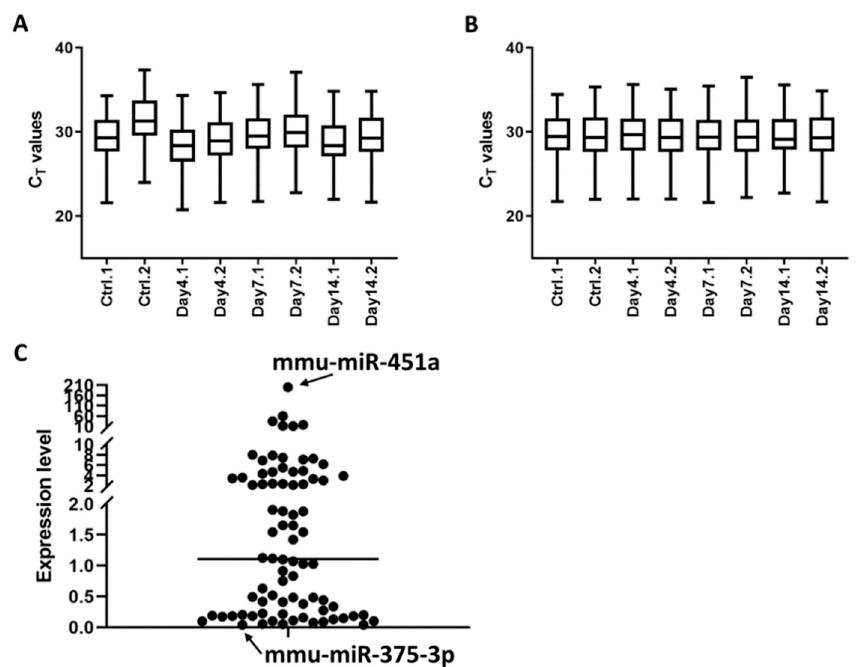
Figure 2. MicroRNA expression profiles of serum exosomes from non-infected and Orientia -infected mice. ( A ) Box plots depicting C T values of 80 miRNAs determined through a custom miRCURY LNA miRNA quantitative PCR array. For each time point, data were generated from two Scheme 3. mice. ( B ) C T values were normalized by mean expression value of all 80 expressed miRNAs and box plots after normalization were shown. ( C ) Relative expression levels of 80 individual miRNA in serum exosomes from non-infected mice after normalization to the array mean expression. Arrow heads point to the two miRNAs with the highest and lowest expression levels. Vertical line denotes median expression level.